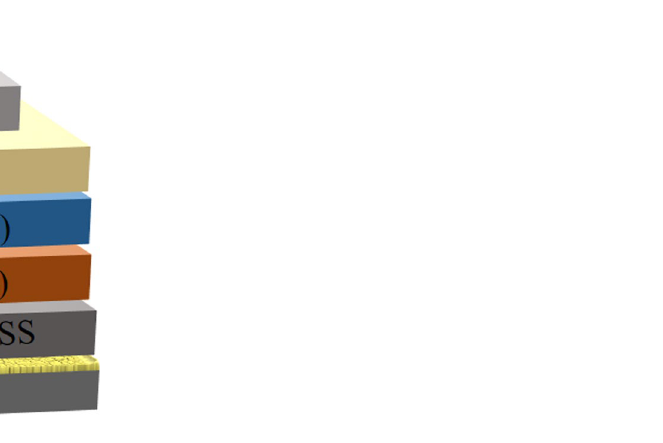
Figure 3. The device structure of the OLED.